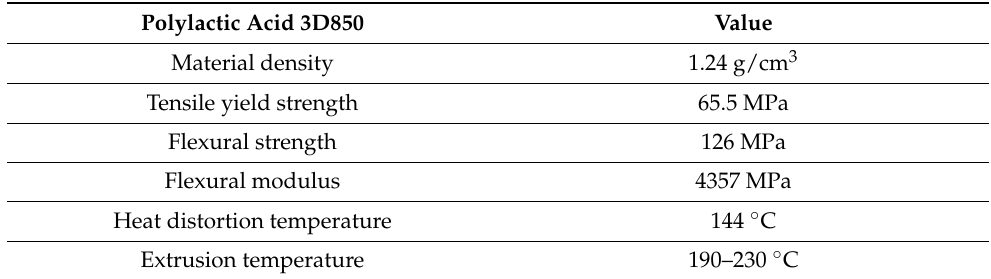
Table 1. Technical data of PLA 3D850 filament taken from the Smart Materials 3D website: www. smartmaterials3d.com/pla-3d850 (2 August 2022).